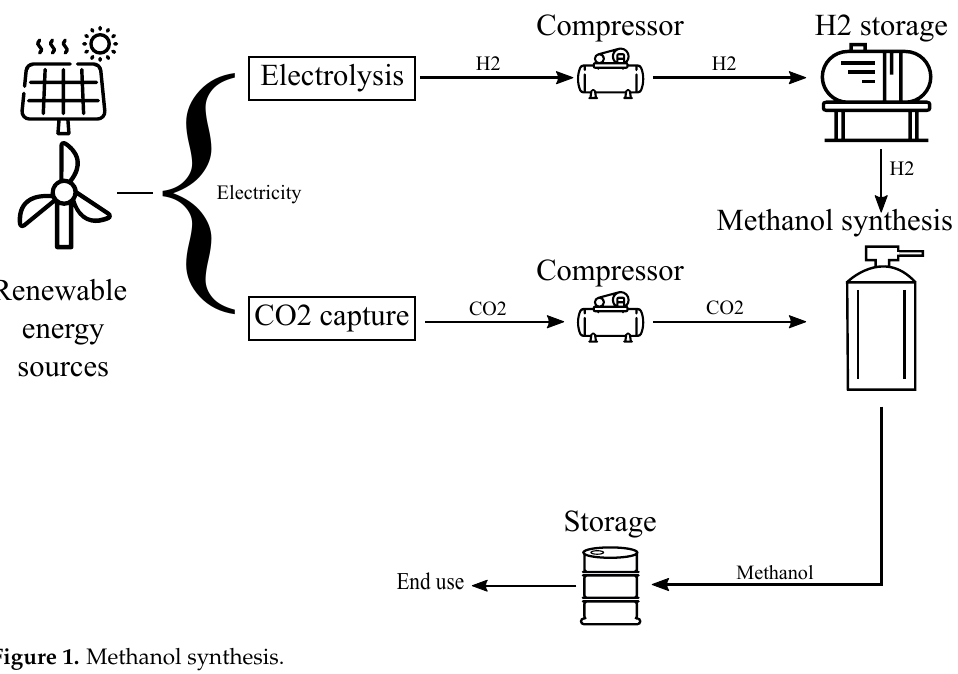
Figure 1. Methanol